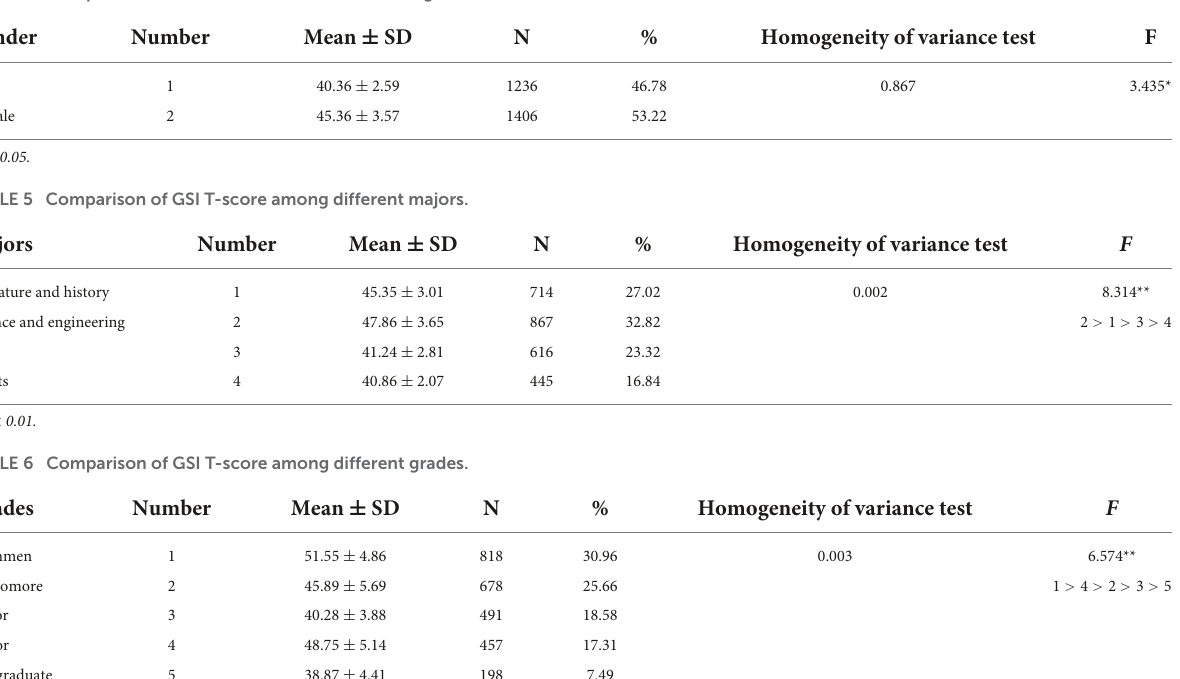
TABLE 4 Comparison of GSI T-score between different genders.